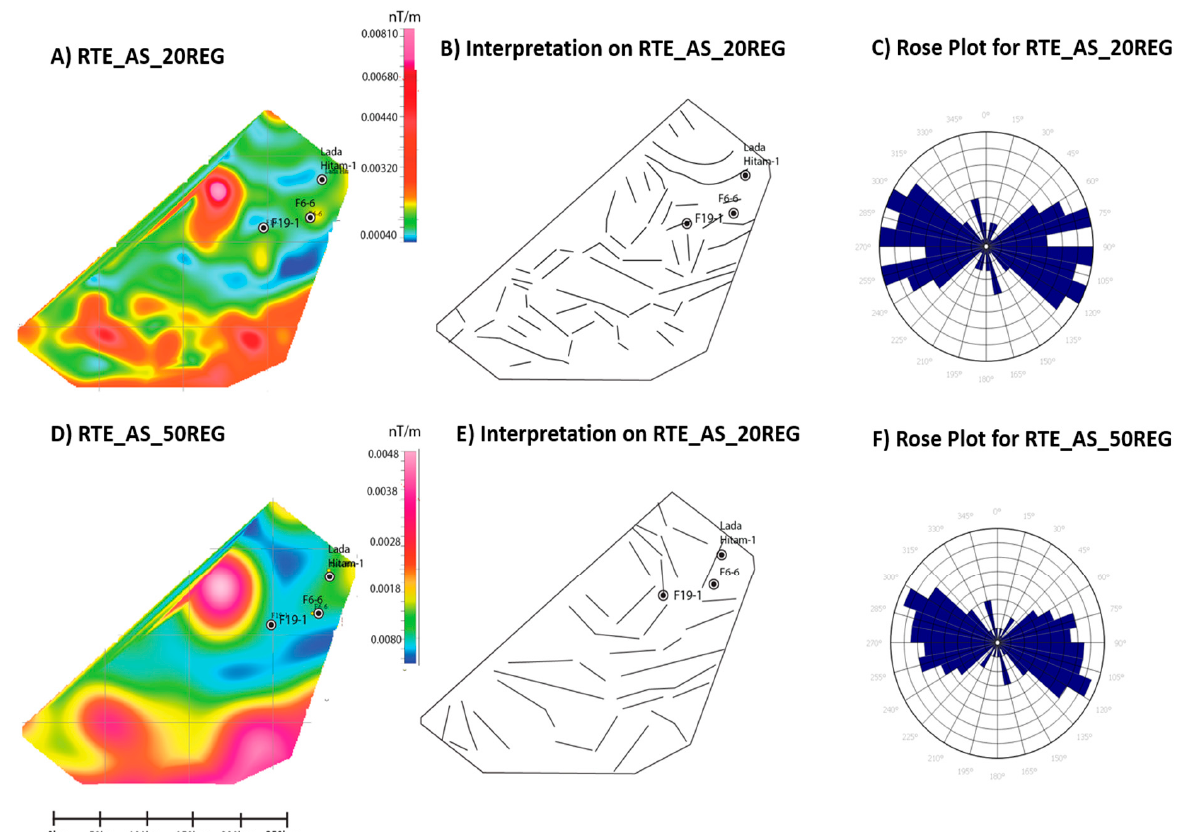
Figure 6. This figure highlights the interpretation on regional analytical signal of original aeromagnetic data from TMI_RTE. ( A ) Analytical signal (Regional) for >20 km wavelength. ( B ) The interpretation of structural trend based on ( A ). ( C ) Rose plot diagram for interpreted structural trend in ( B ), showing NW-SE, E-W and NE-SW orientations. ( D ) Analytical signal (Regional) for >50 km wavelength. ( E ) The interpretation of structural trend based on ( D ). ( F ) Rose plot diagram for interpreted structural trend in ( E ), showing NW-SE to E-W orientations